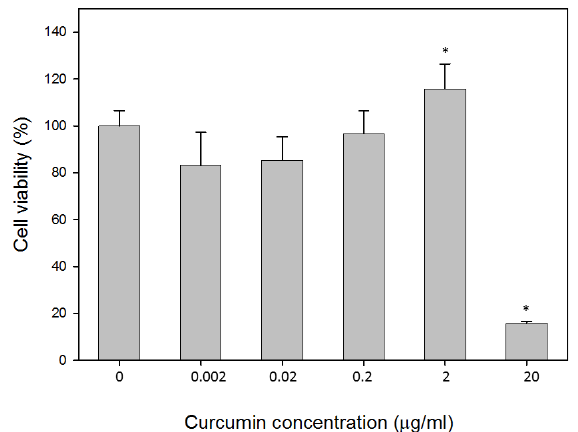
Figure 1. Effects of curcumin on L929 cell viability. Cytotoxicity was determined using MTT assay after 24 h treatment with the indicated concentrations. Values are expressed by mean ± S.D. Asterisk (*) indicates statistically significant differences ( p <0.05) when compared with the control.